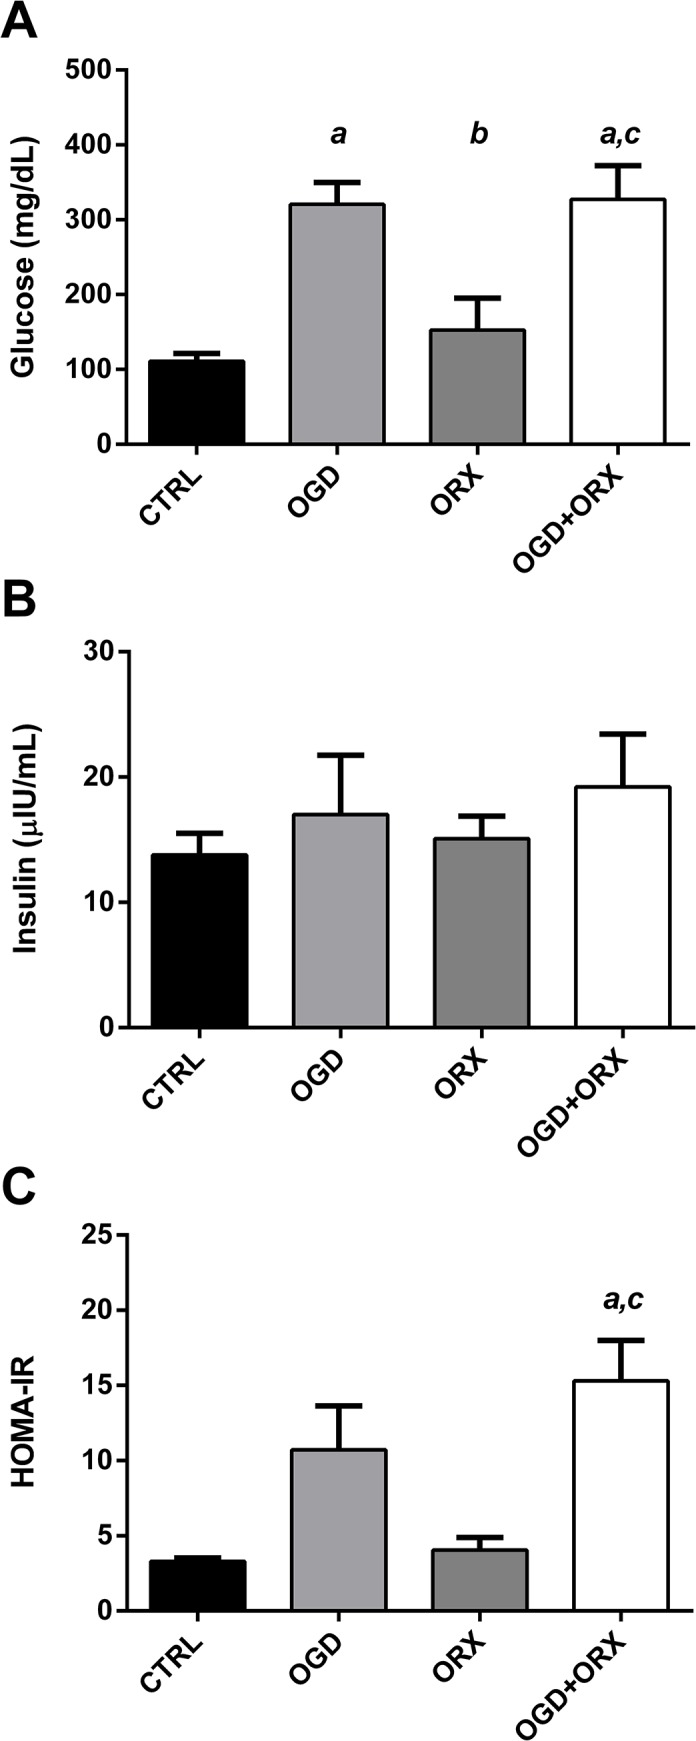
Homeostatic Model Assessment of Insulin Resistance (HOMA-IR).(A) Serum glucose concentrations. (B) Serum insulin concentrations. (C) Calculated HOMA-IR scores (in arbitrary values). CTRL–control, OGD–obesogenic diet-fed, ORX–orchiectomised. Letters denote significant differences between respective groups, p<0.05 (a vs. CTRL, b vs. OGD, c vs. ORX).